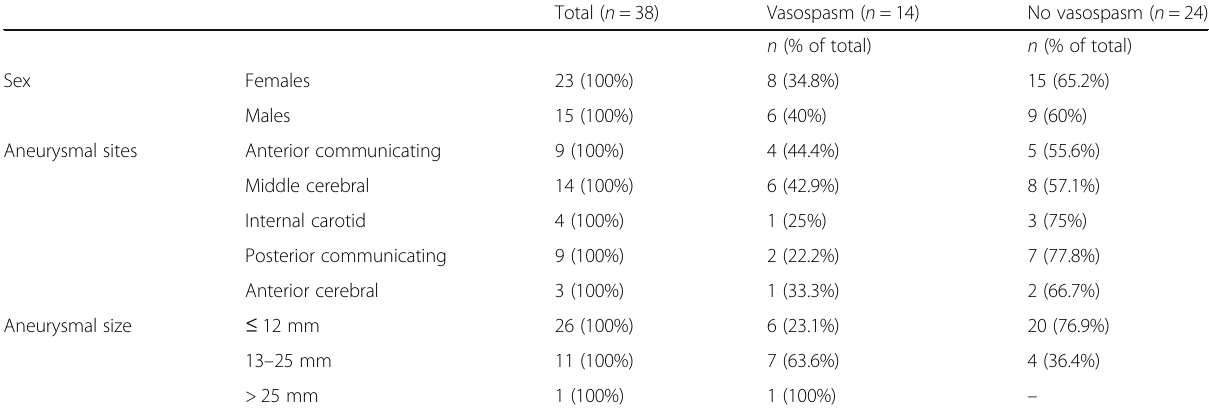
Table 2 The rate of development of vasospasm regarding patients ’ sex, aneurysmal sites, and sizes